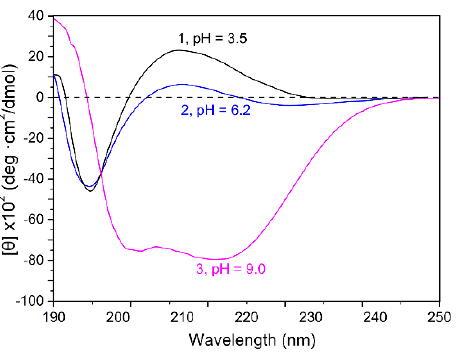
Figure 8. CD spectra of PE 607 - b -PLL 275 polymeric micelles in aqueous solutions for different pH val- ues.